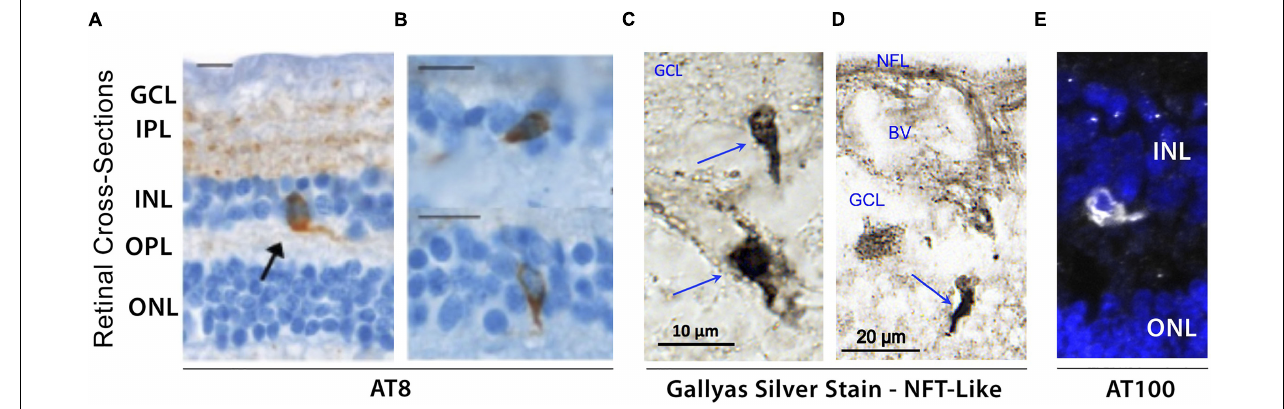
FIGURE 4 | Evidence of hyperphosphorylated pTau inclusions in AD retina. (A–E) Representative micrograph images of retinal cross-sections from AD patients following (A,B) immunostaining with AT8 mAb against phospho-tau (Ser202, Thr205), revealing intracellular pTau aggregates in both inner and outer nuclear layers (INL and ONL), and plexiform layers (IPL and OPL). Scale bars: 10 µ m; (C,D) Higher magnification images of inner retina stained with Gallyas silver showing neurofibrillary tangle (NFT)-like structures in ganglion cell layer (GCL). (E) Immuofluorescence staining of AT100 mAb against phospho-tau (Thr212, Ser214) showing punctate aggregates and intracellular inclusions in INL. Images and data of panels (A,B) are adapted from Schön et al. (2012). Images and data of panels c-d are reproduced from Koronyo et al. (2017) with permission of ASCI via Copyright Clearance